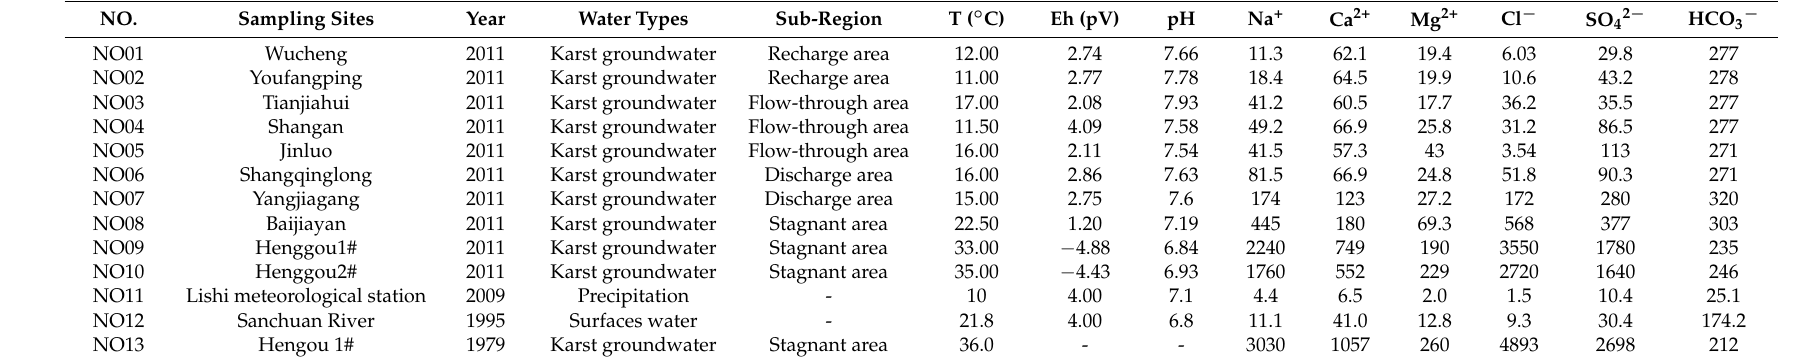
Table 1. Physico-chemical data of water samples in Liulin spring area